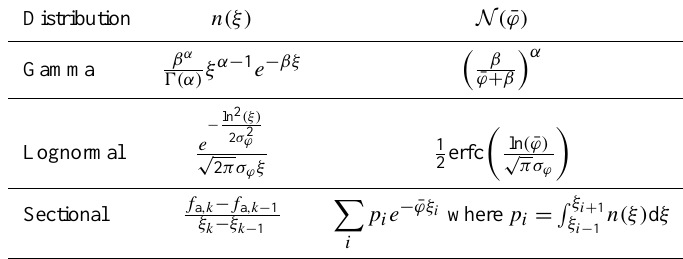
Table 1. N ( ¯ ϕ) and n(ξ) for gamma, lognormal and sectional NPDFs; ¯ ϕ is the characteristic ice nucleation coefficient defined in Sect. 2.1, 0 is the gamma function, and f a ,k represents the fraction of the aerosol population with cumulative ice nucleation probability below 1 − exp ( − ξ k ¯ ϕ) . The lognormal N ( ¯ ϕ) is approximated using N ( ¯ ϕ) ∝ R 1 /